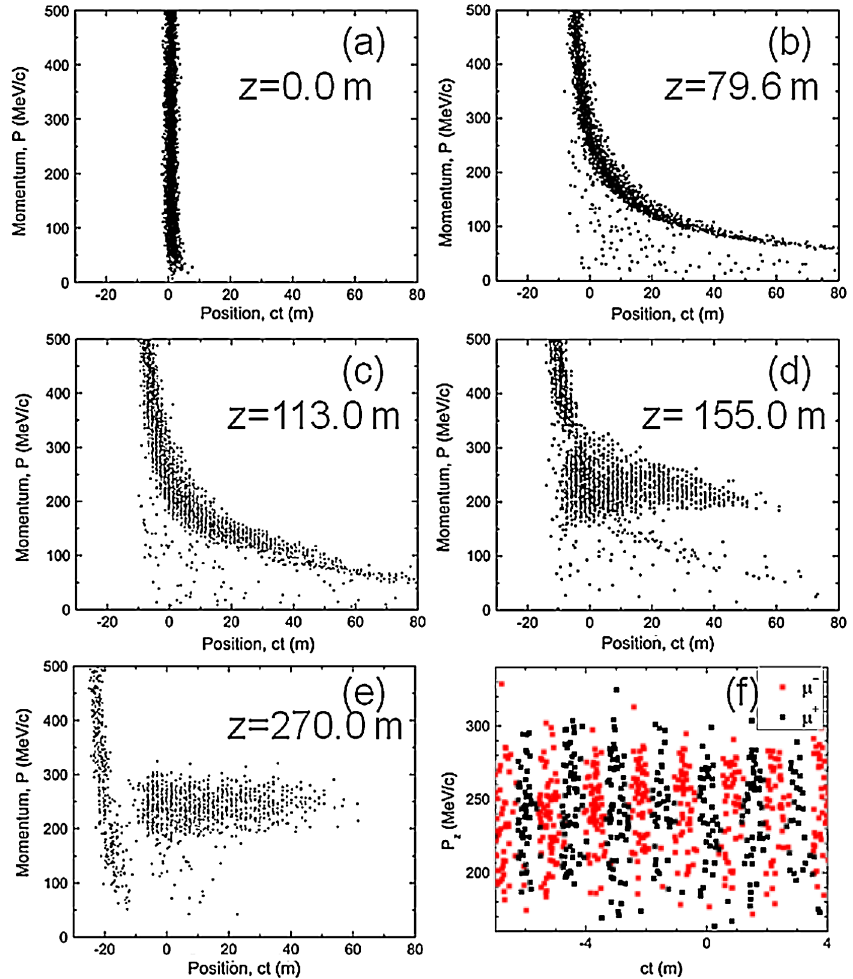
FIG. 7. Simulation results of the evolution of the longitudinal phase space along the drift, buncher, phase rotator, and cooler for our proposed magnetically insulated front-end channel. (a) Pions and muons as produced at the target; (b) muons after the 80 m drift; (c) at the end of the buncher; (d) at the end of the rotator; (e) at the end of the cooler; (f) a sample from the train of interleaved (cid:1) þ and (cid:1) (cid:2) bunches exiting the cooling